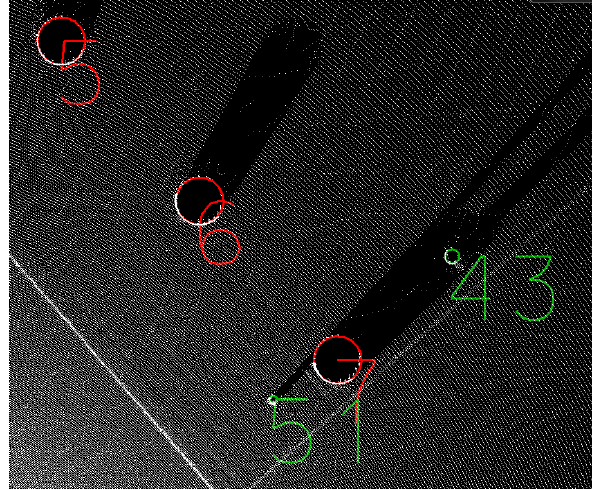
Figure 6. A detail of measured reference pole locations from close-to-ground laser points.